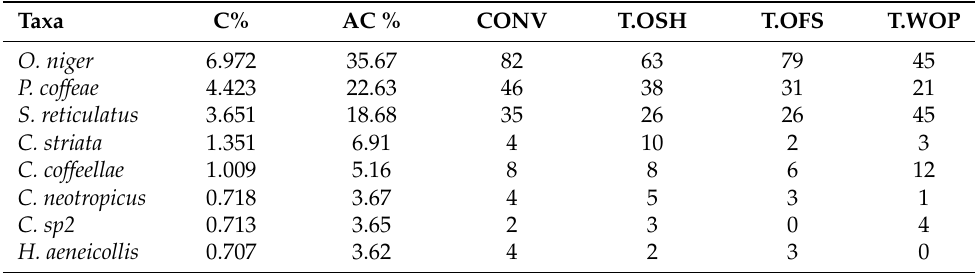
Table 1. The percentage of similarity (SIMPER) of all treatments with an overall dissimilarity of 19.54%, showing average species contribution (C%), average dissimilarity (AC%), and average in each treatment for the species. The production system treatments were conventional (CONV), and transitioning to organic shaded (T.OSH), organic full-sun (T.OFS), and without pesticide (T.WOP). February 2013 to December 2014. Campo do Meio and Guap é , MG, Brazil. Taxa